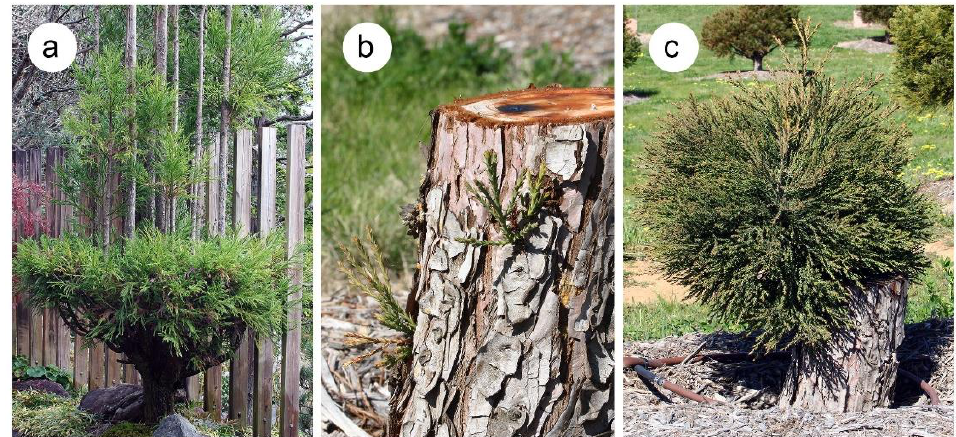
Figure 2. Epicormic resprouting in two species of the Cupressaceae. ( a ) Cryptomeria japonica . This species is used for bonsai and topiary and this example in a Japanese botanical garden had been pruned to form several leaders of equal dominance. ( b , c ) Sequoiadendron giganteum . This species is known to resprout from the stumps of younger trees, as is shown here for trees in an arboretum. Table 1. Gymnosperm families and genera with at least one ‘strongly’ resprouting species, based on information in Supplementary Table S2. The number in brackets after the family name indicates the number of genera in that